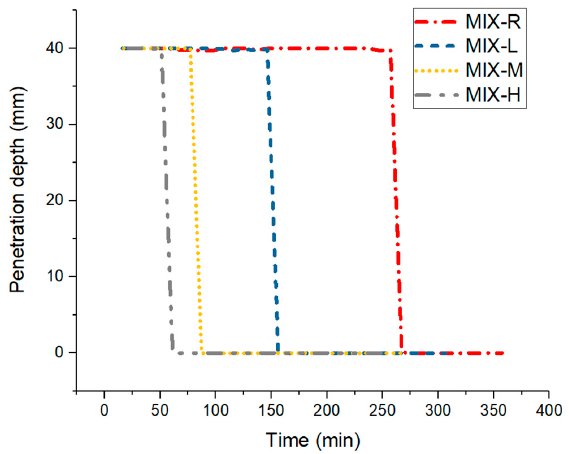
Figure 5. Results of the penetration resistance test by a Vicat apparatus.